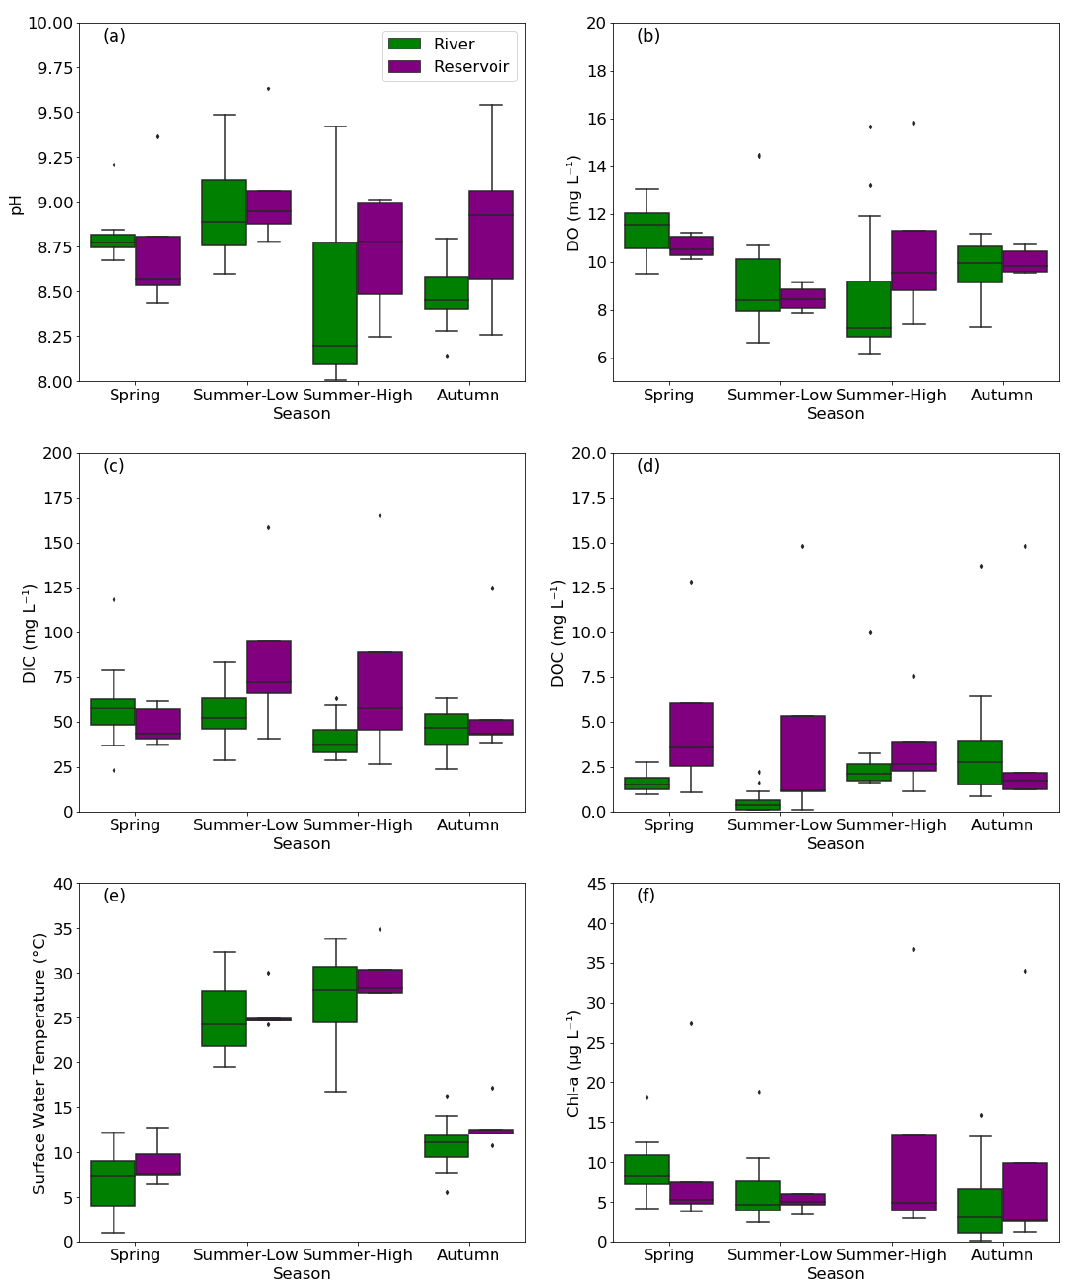
Figure 2. The boxplots summarizing the water-quality parameters, including pH ( a ), DO (dissolved oxygen) ( b ), DIC (dissolved inorganic carbon) ( c ), DOC (dissolved organic carbon) ( d ), surface water temperature ( e ), and Chl-a (chlorophyll-a) ( f ), of rivers and reservoirs in the KRB. The dots represent the outliers, which are defined as the value lower than Q1-1.5 * interquartile range (IQR) or higher than Q3 + 1.5 * IQR. Summer-Low and Summer-High represent the summer low-flow period and summer high-flow period,